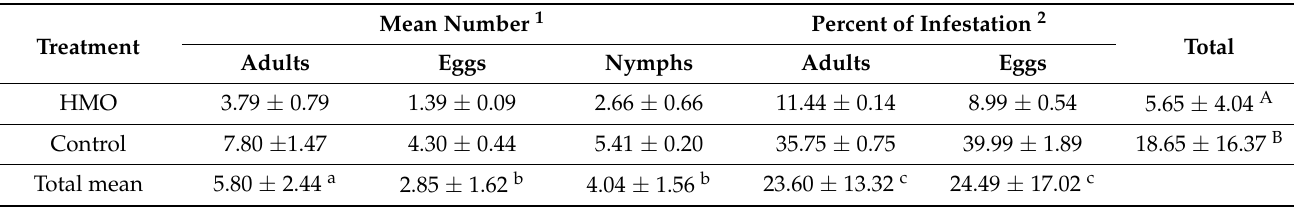
Table 1. Effect of horticultural mineral oil (HMO) on numbers and flush shoot infestation levels of Diaphorina citri during August 2012.